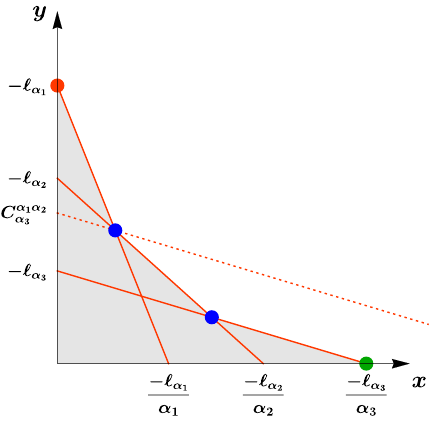
Figure 3 . The Lund plane describing the region of phase space for the measurement of three angularities in which the most logarithms may be resummed. The various modes are denoted by the green (collinear), orange (soft) and blue (collinear-soft) dots. The dotted line serves to indicate the point C (cid:11) 1 (cid:11) 2 , which shows up in the boundaries of the region of phase (cid:11) 3